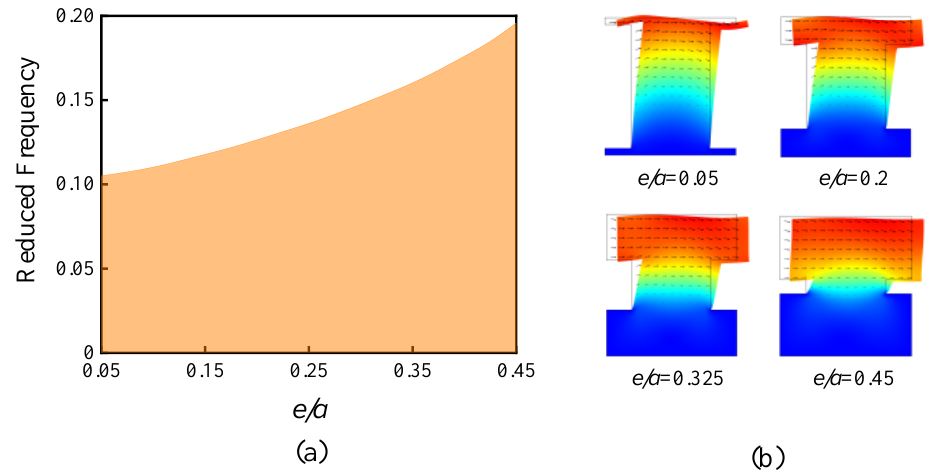
Figure 9. Relationship between the band gap characteristic and the parameter ratio e / a . ( a ) Relationship function curve and ( b ) eigenmode displacement vector field.